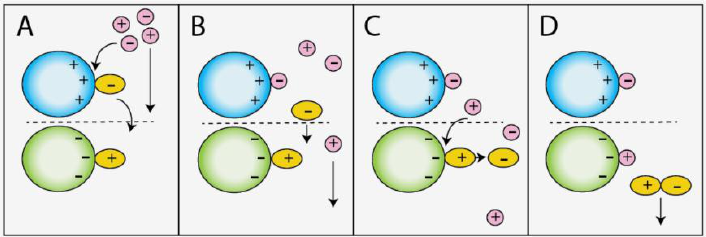
Figure 4. Proposed desorption mechanism of bound DMPIm + and NTf 2 − ions; ( A ) NTf 2 − is displaced by eluent anion, ( B ) Free NTf 2 − is carried down the column, ( C ) Interaction between bound DMPIm + and NTf 2 − facilitates displacement of DMPIm + , ( D ) [DMPIm][NTf 2 ] is eluted as an ion pair.